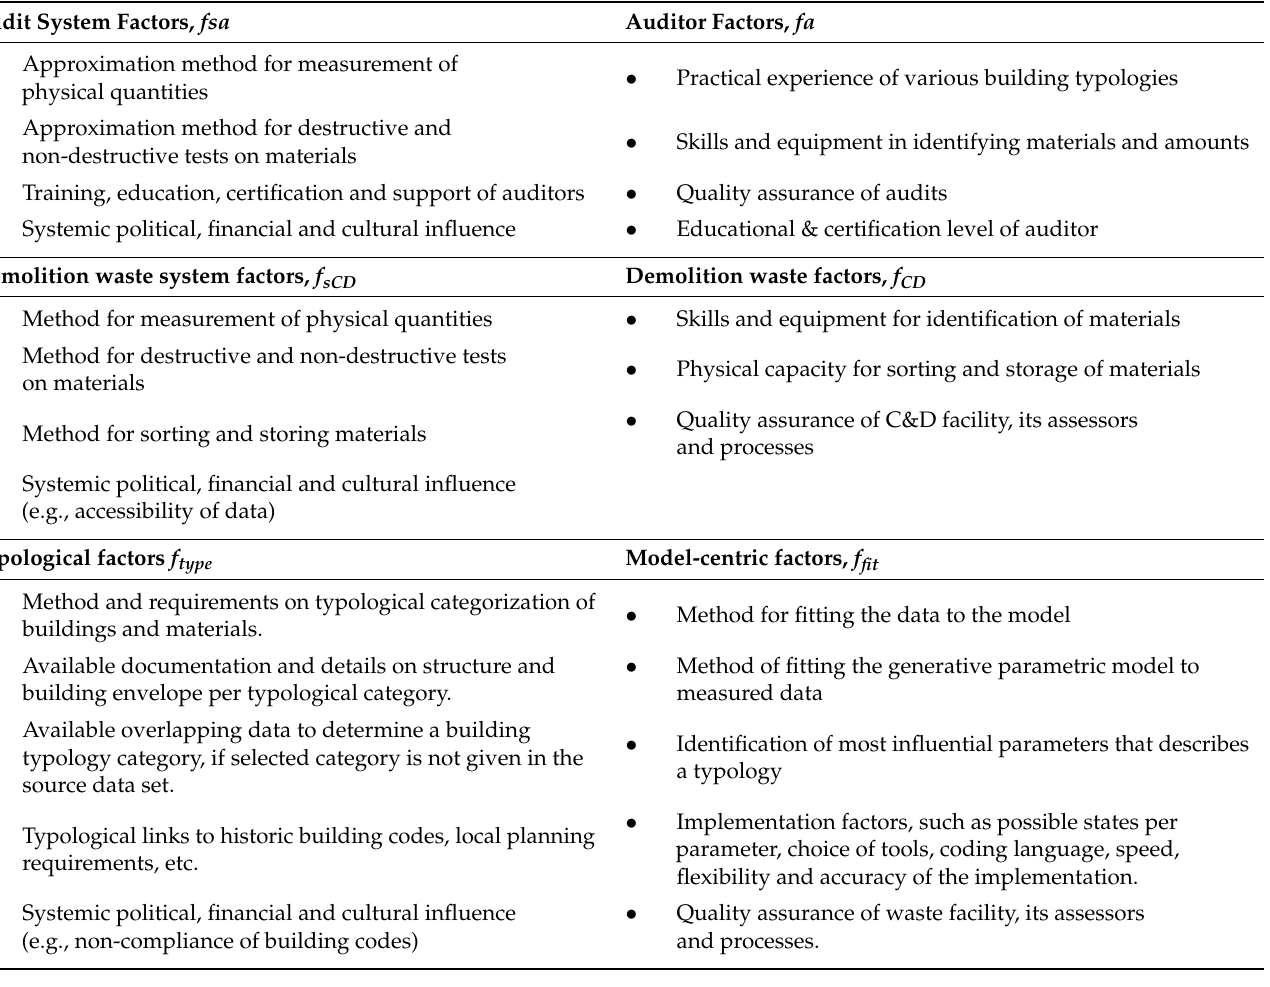
Table 1. Factors/flow origins identified for BMC